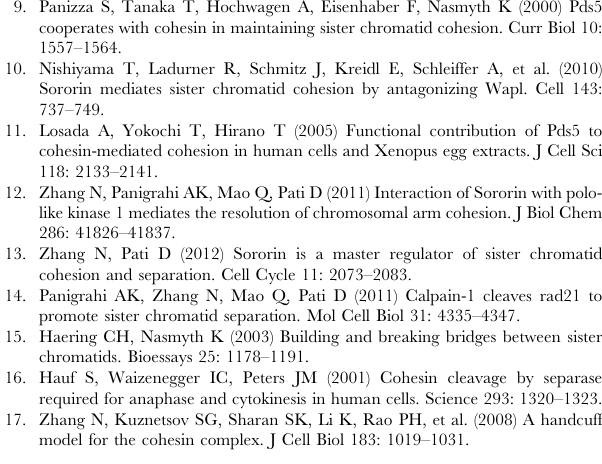
types (e.g. blue for positively charged, red for negatively charged, green for hydrophobic, silver for polar, etc). PROF_sec predicts the secondary structure (H= Helix). Rel_Sec shows the reliability index of the PROF_sec prediction (0 =low, 9= high). Figure S3 Mutations on middle part SA1/2-binding motif of Rad21 do not affect Rad21-Rad21 interact and co-immunopre- cipitate Smc1/3. 293 T cells were transfected with pCM2 MT Rad21 (and pFlag CMV2 Rad21 for (B)). Empty vector was used as control. Co-immunoprecipitation was performed using whole cell lysate. ( A ) Immunoblotting shows the cohesin core subunits including endogenous Rad21 were co- immunoprecipitated by Myc-Rad21 WT and mutants. ( B ) Immunoblotting of the co-IP of Flag-Rad21 and Myc-Rad21, which does not affect by the mutation on the middle part of SA1/2 binding motif of Rad21.